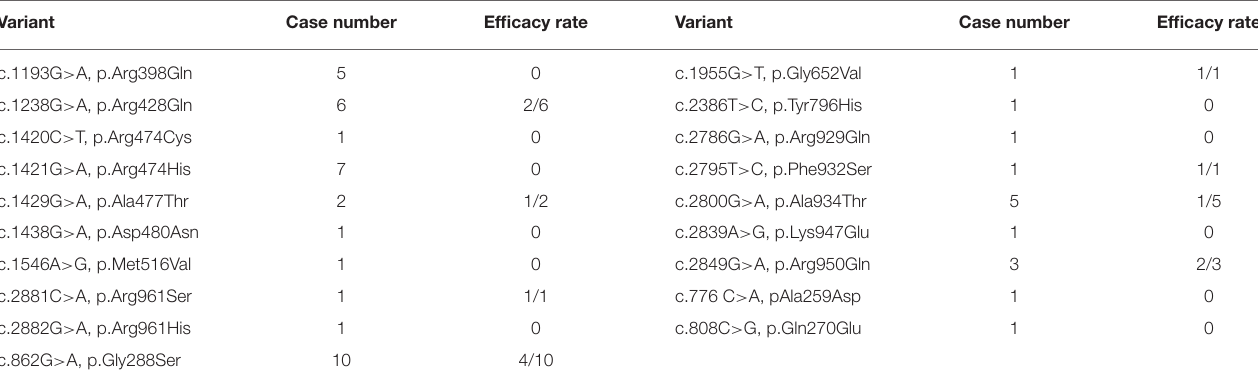
TABLE 1 | Patients with quinidine treatment (including our patients) (5, 12, 15, 16).